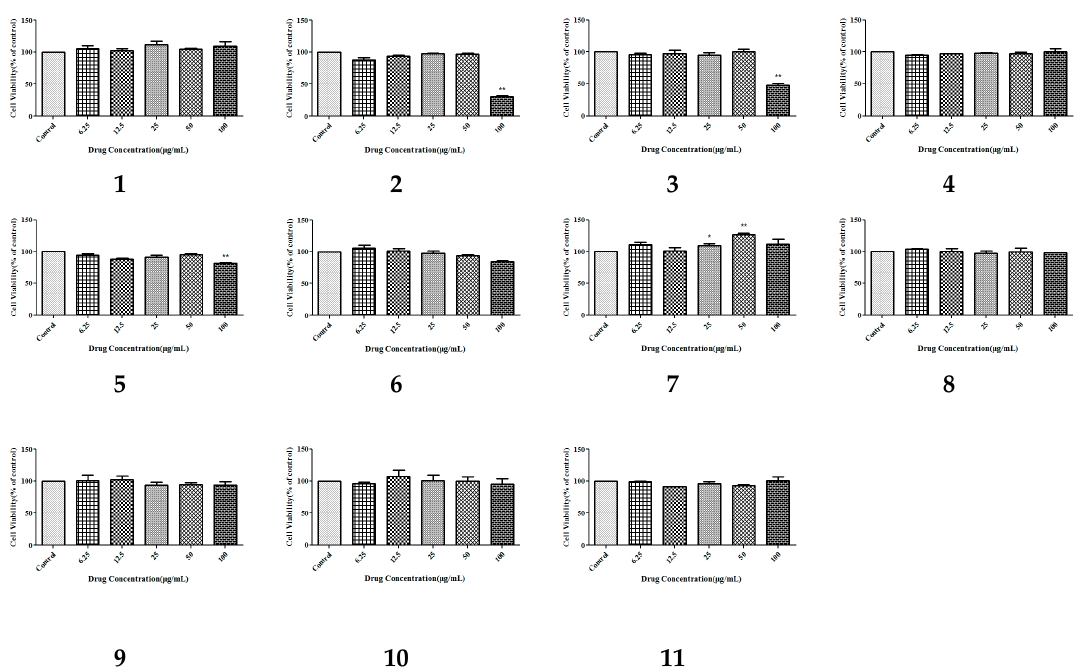
Figure 3. The effect of the isolated compounds on the survival rate of HepG ‐ 2 human hepatocellular carcinoma cells. The cells were pretreated with concentrations (6.25, 12.5, 25, 50, and 100 μ g/mL) of compounds 1 – 11 for 1 h. The data show the mean ± SD of three independent experiments performed in triplicates.